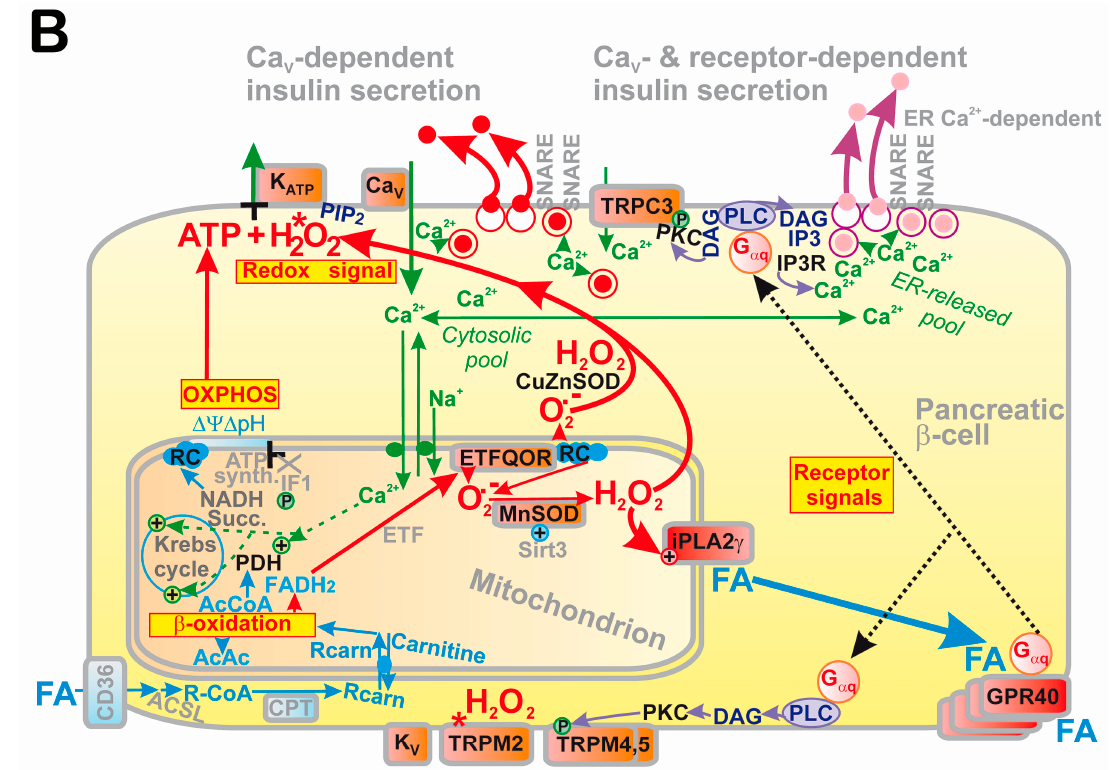
Figure 8. ( A ) Complex mechanism of FASIS and ( B ) GPR40 receptor part. FASIS is predominantly mediated by the GPR40 receptor. There are controversies over whether FAs bound to serum albumin and those cleaved by lipoprotein lipase can be transported into β -cells by FA transporter CD36 under fasting conditions. Such FA transport and cleavage of triglycerides (TG) to monoacylglycerols (MAG) and FA, however, take place when postprandial chylomicrons reach the rich